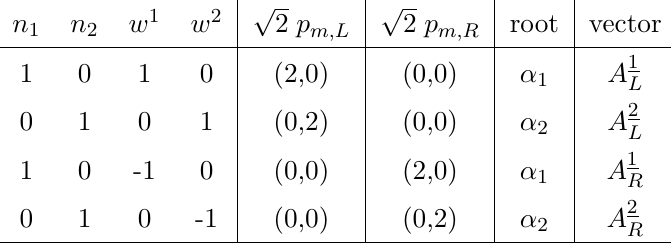
(cid:2) SU(2) 2 enhancement L R